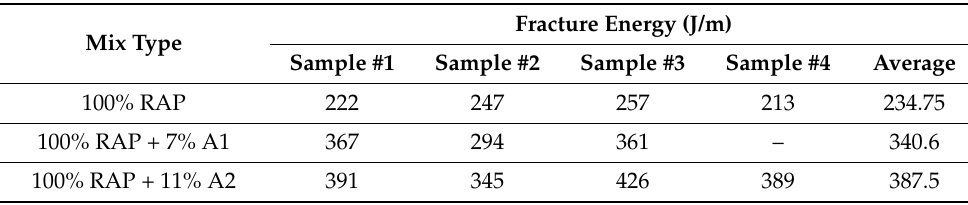
Table 5. Fracture energy (J/m) of all the